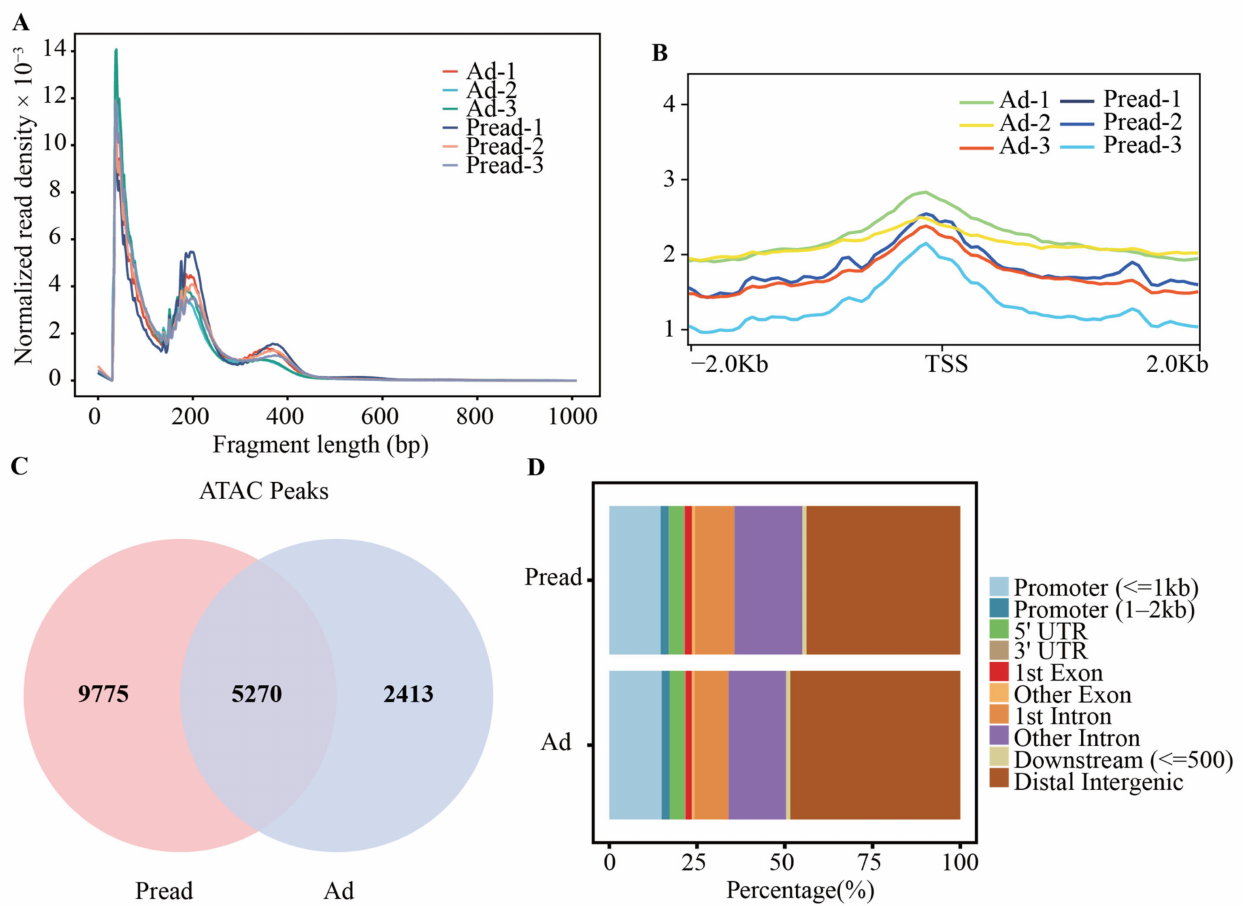
Figure 2. The characteristics of accessible chromatin in preadipocyte and adipocyte. ( A ) The fragment size distribution of each sample. A large proportion fragment size was less than 100 bp, which represents the regions of chromatin accessibility. The peaks at the 200 bp and 400 bp positions represent mononucleosomes and dinucleosomes. ( B ) Distribution of all reads relative to the position of TSS ± 2 Kb. The ordinate represents the ATAC-seq signal intensity. ( C ) Venn diagram showing the peak overlap between Pread and Ad groups. ( D ) The distribution of peaks among different genomic regions (promoter, 5’UTR, 3’UTR, exon, intron, downstream and distal intergenic) in Pread and Ad